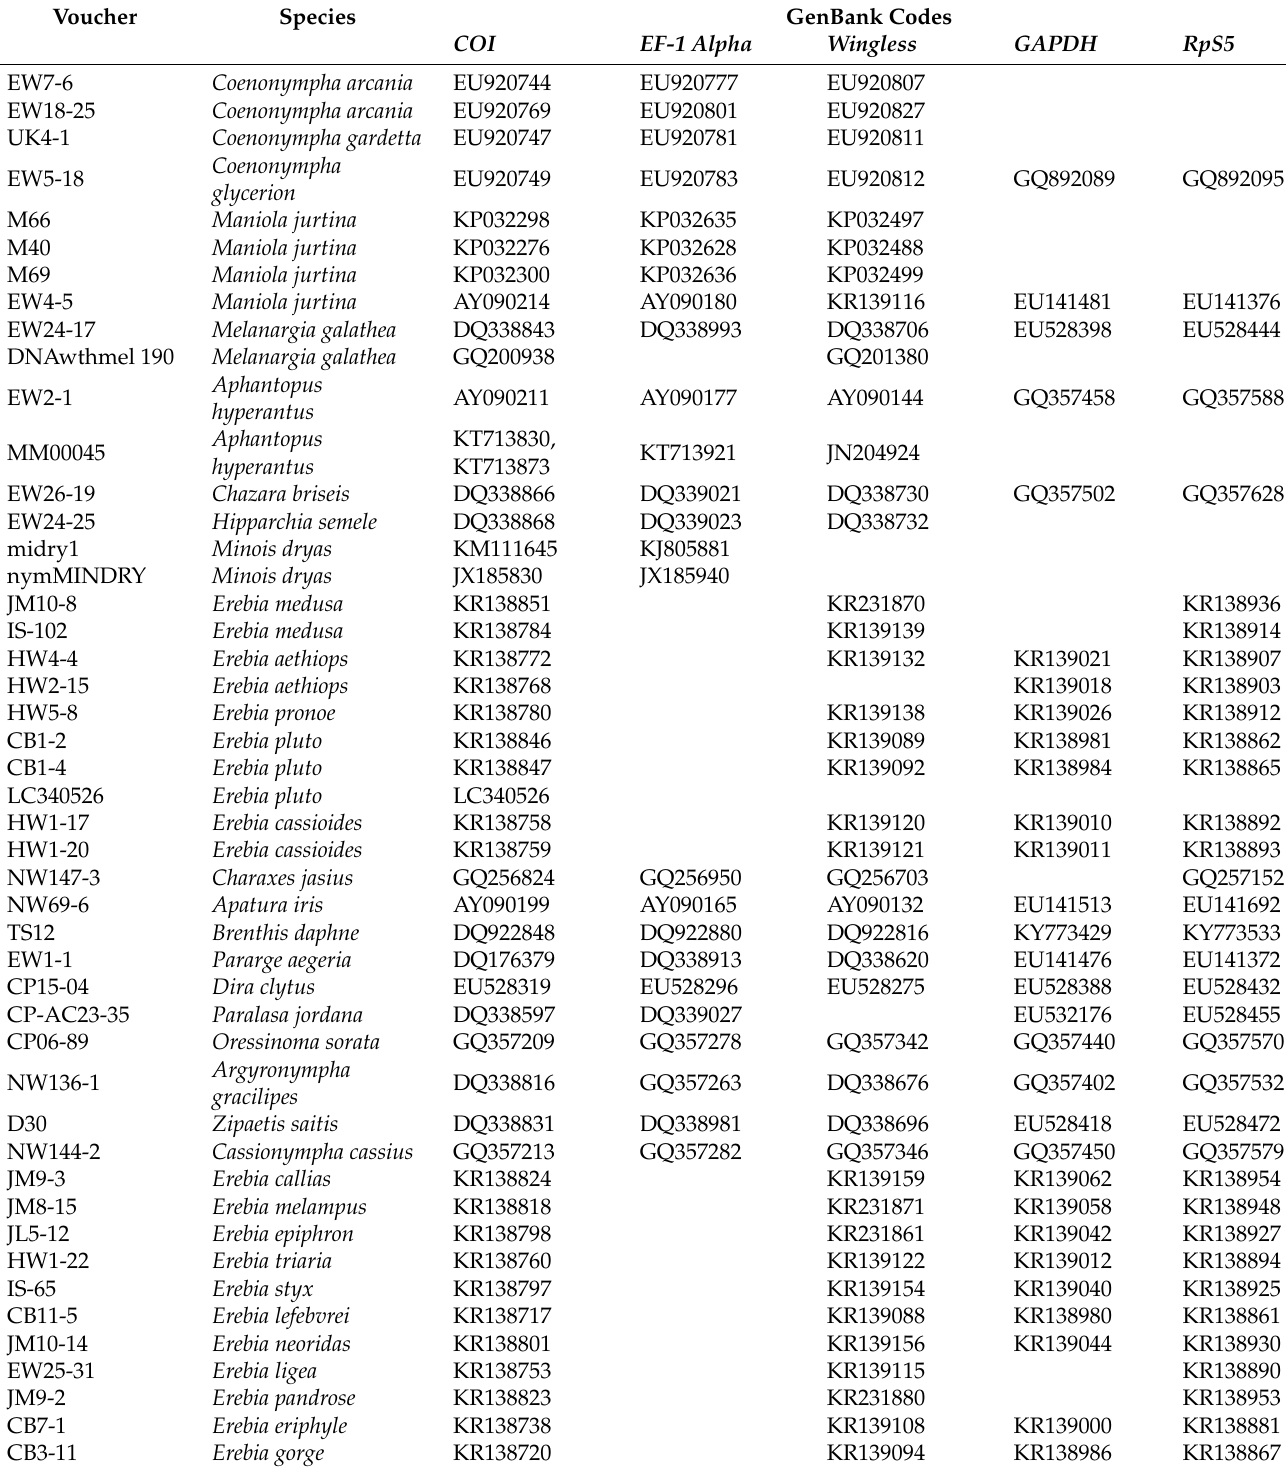
Table A1. List of specimens and sequences used as a backbone phylogeny for Satyrinae butterflies with examined cryoprotectant concentrations and supercooling